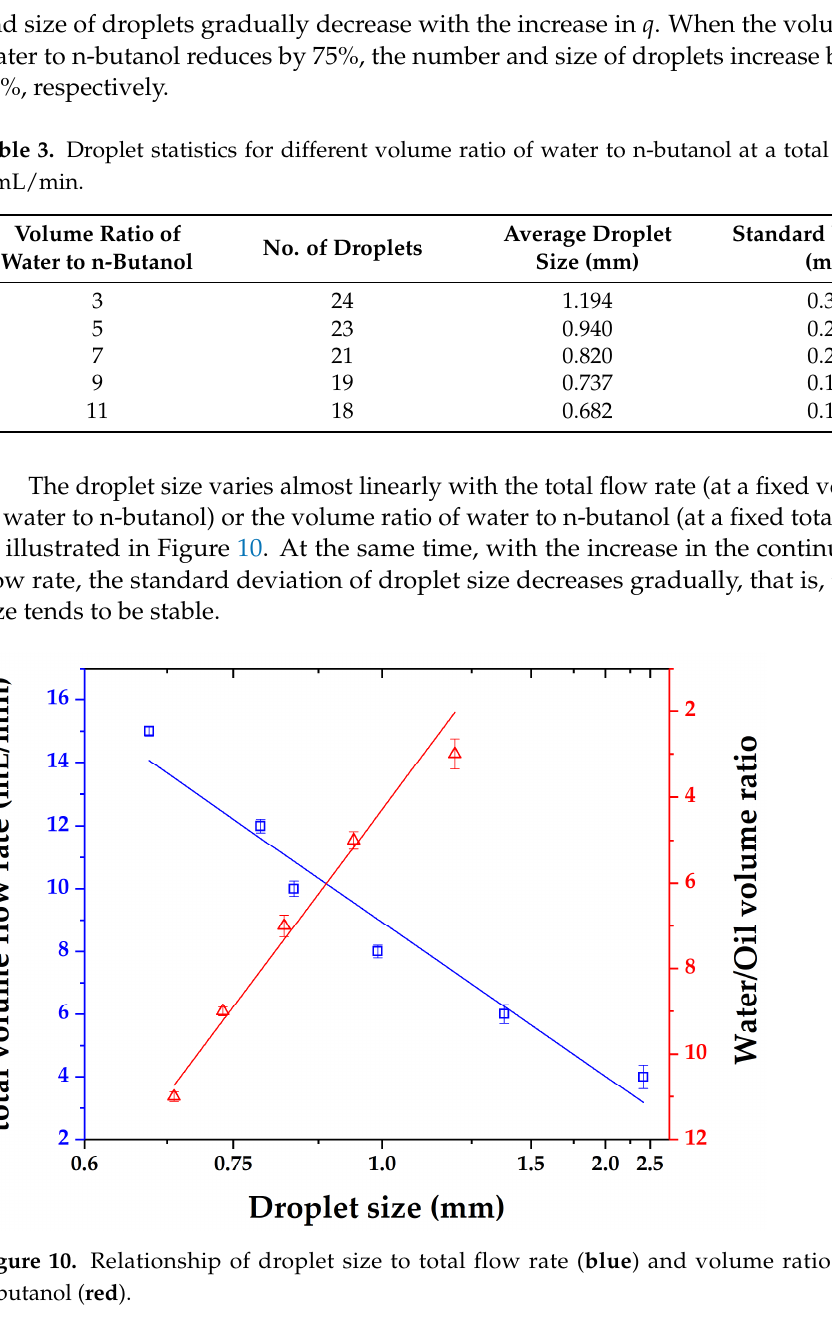
Table 3. Droplet statistics for different volume ratio of water to n-butanol at a total flow rate of